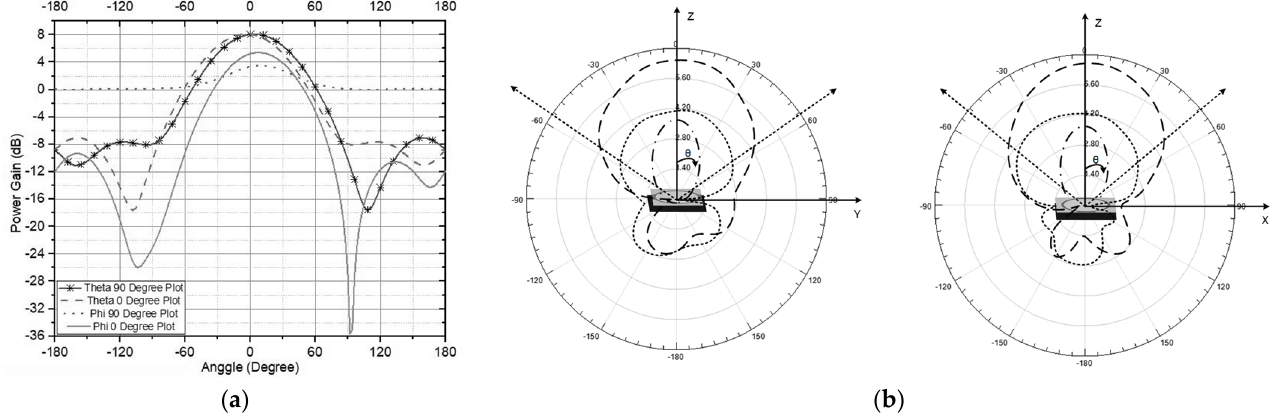
Figure 12. Radiation Pattern of the Double U slot with the dual feed CP Antenna ( a ) Rectangular plot ( b ) Radian Plot.